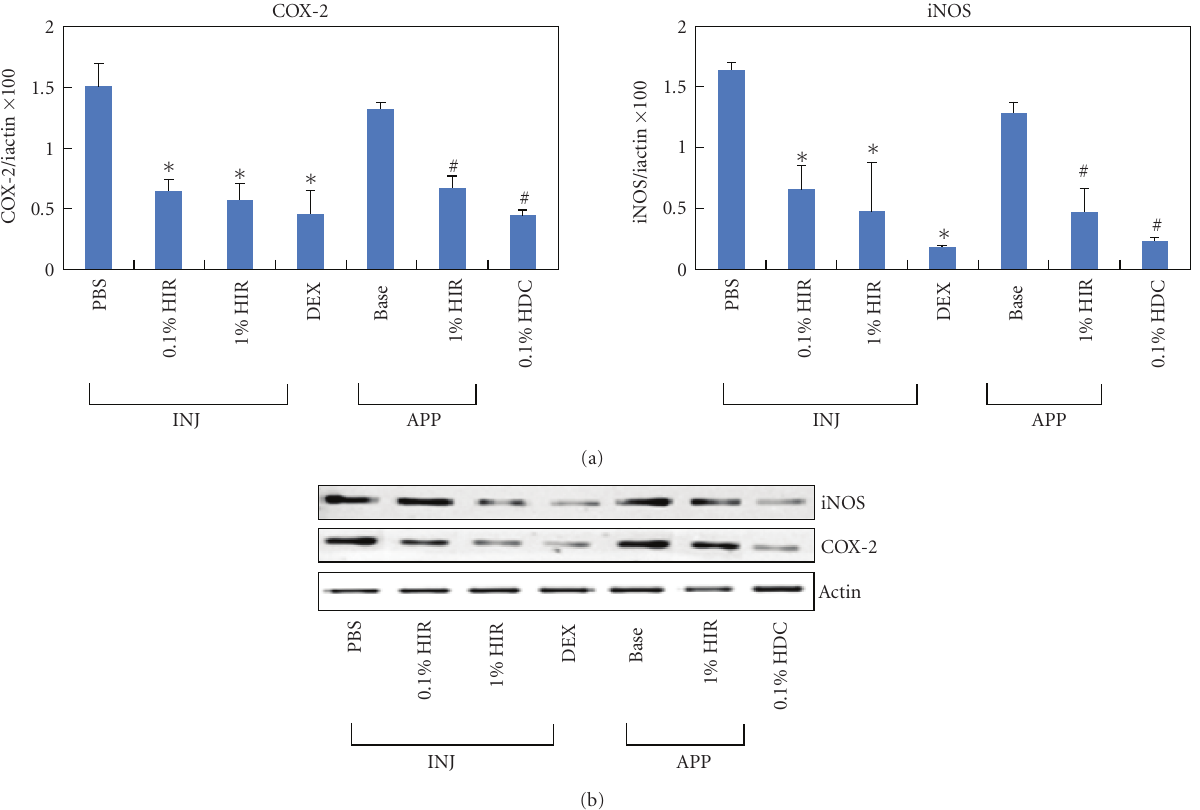
Figure 5: (a) COX-2 and iNOS expressions in AD-like lesions. (A) Real-time RT-PCR. (b) Western blots. Columns show means and standard deviations. The analyses were repeated at least three times. Data are mean ± S.D. HIR: Hirsutenone, DEX: dexamethasone, Base: Baseline, HDC: hydrocortisone cream, INJ: injection, APP: application. ∗ P < .05 compared with the PBS group. # P < .05 compared with the Base group. n =